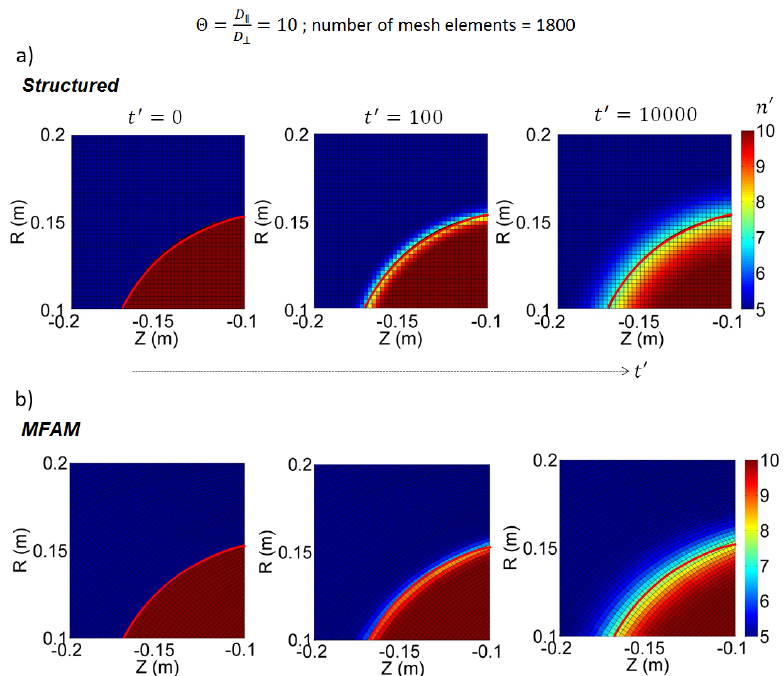
Figure 13. Temporal evolution of the anisotropic diffusion problem solution in Cartesian ( a ) and MFAM ( b ) meshes. Variables are non-dimensionalized.